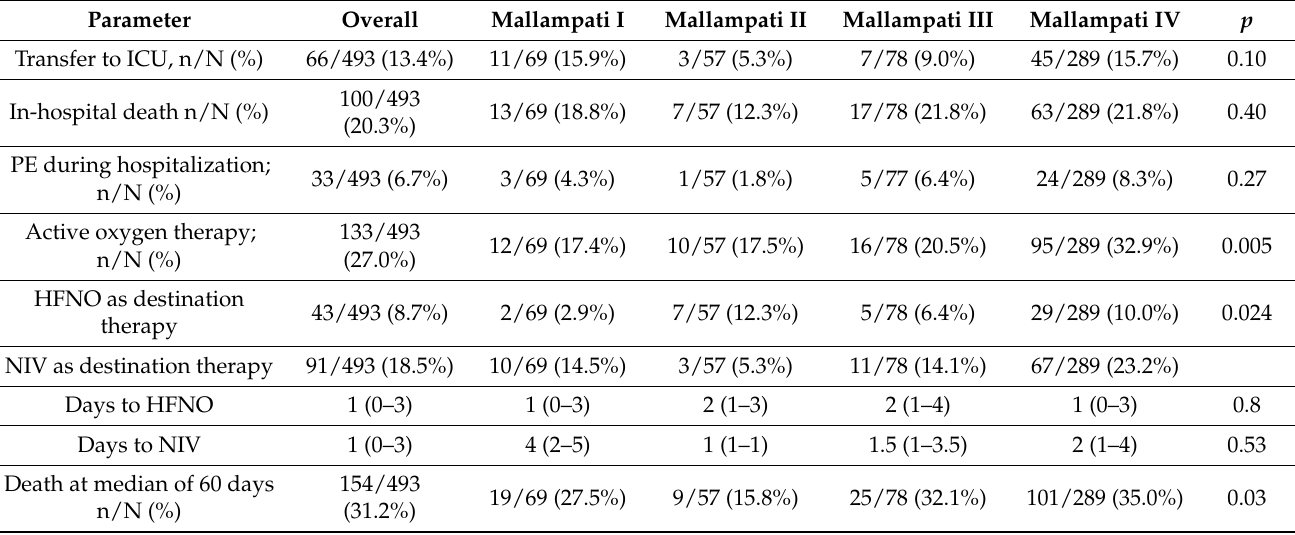
Table 3. Outcomes in patients with COVID-19 based on Mallampati score assessment.